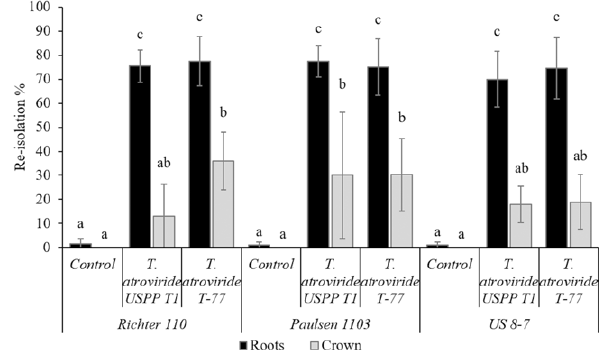
Figure 1. Mean proportions (%) of re-isolations of Trichoderma atroviride T-77 and T. atroviride USPP T1 from the grapevine rootstock cultivars ‘Richter 110’, ‘Paulsen 1103’ and ‘US 8-7’. Re- isolations were made from plant roots and crowns 21 d post-inoc- ulation. Each of the data points shows the average of 25 replicates (five biological replicates and five technical replicates). Error bars indicate standard deviations of the means. Different letters accom- panying the means indicate significant differences ( P ≤ 0.05; Tukey Contrasts).